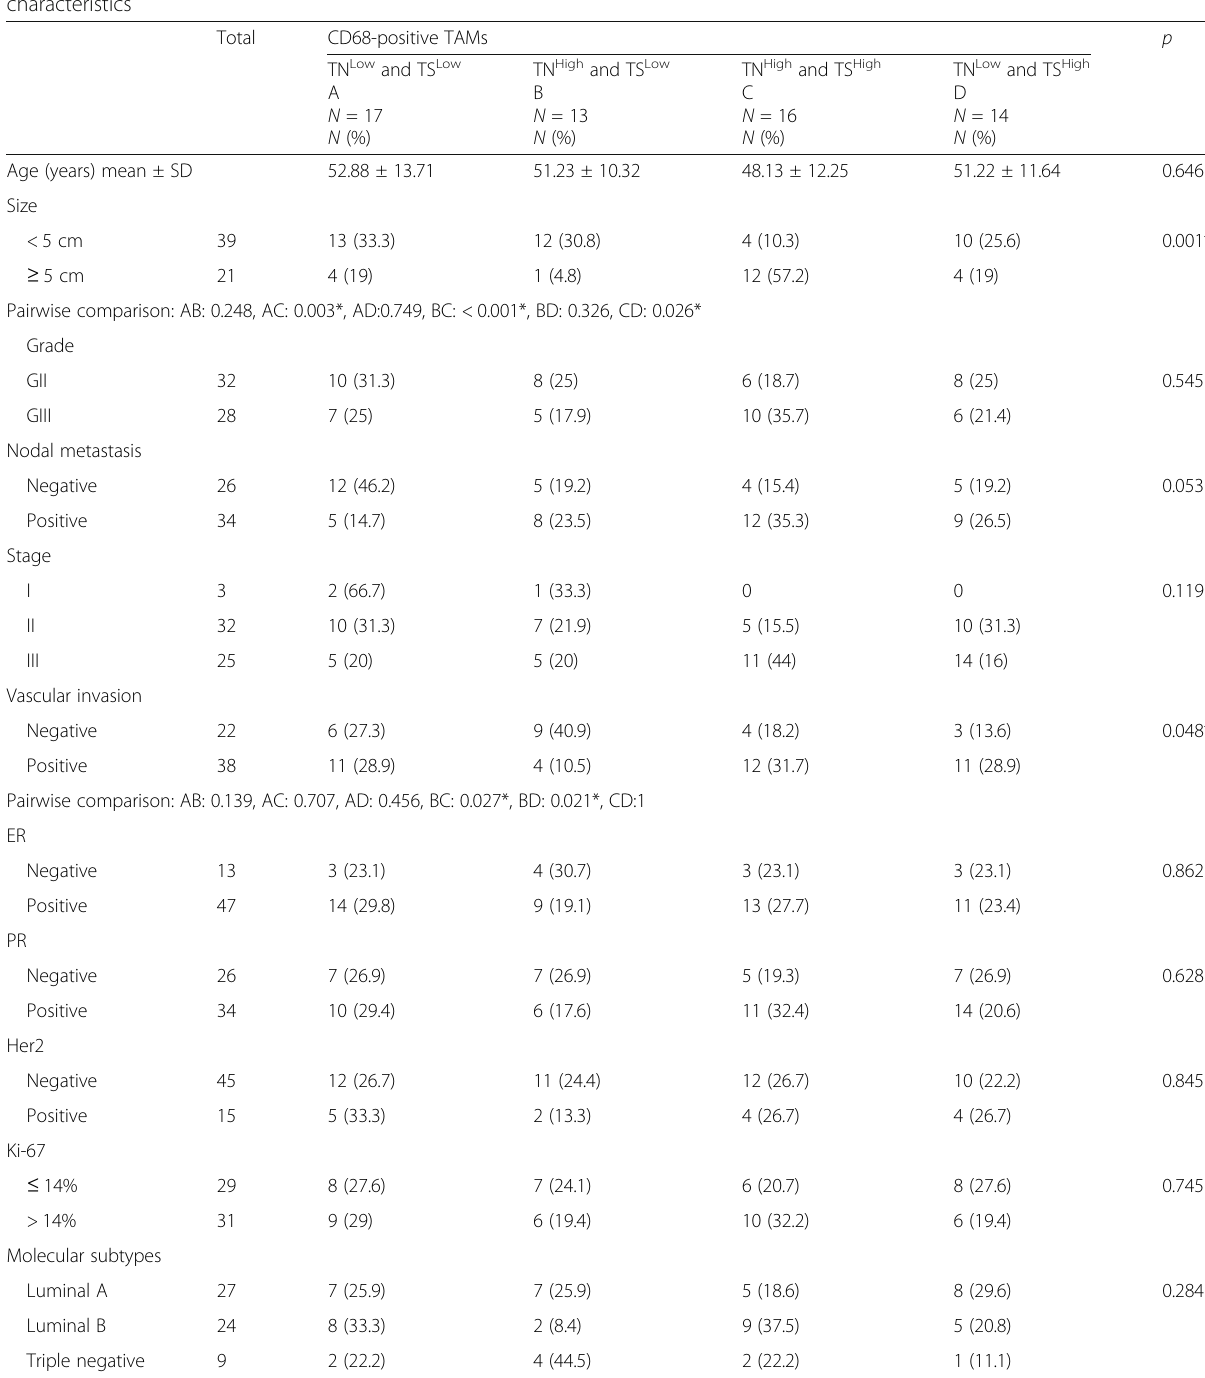
Table 4 Relation between combined densities of CD68 expression in both tumor nest and stroma and clinicopathologic